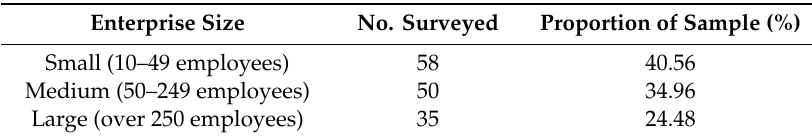
Table 2. Characteristics of the enterprises surveyed (N =